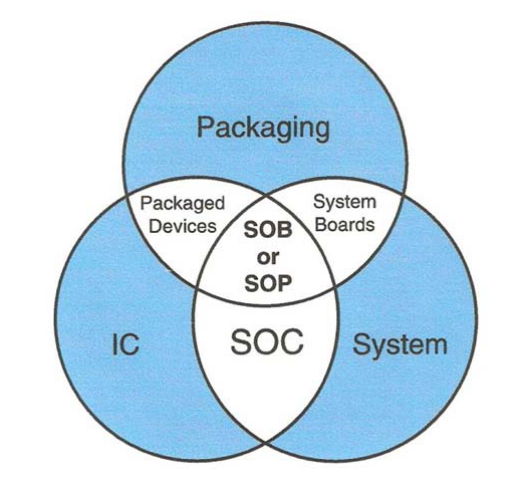
Figure 3. Integration of IC packaging and